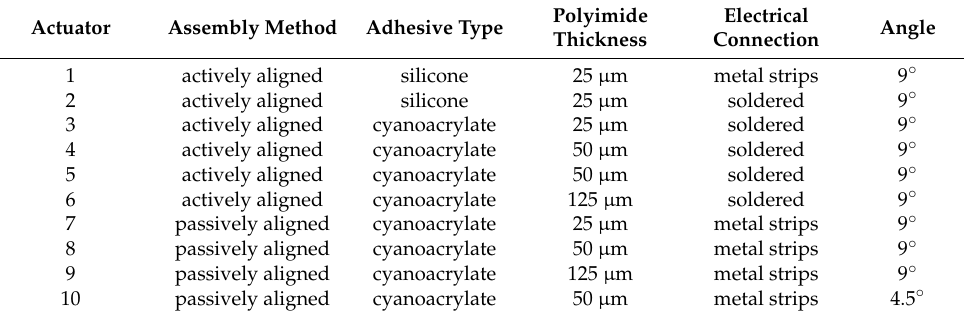
Table 1. Actuator